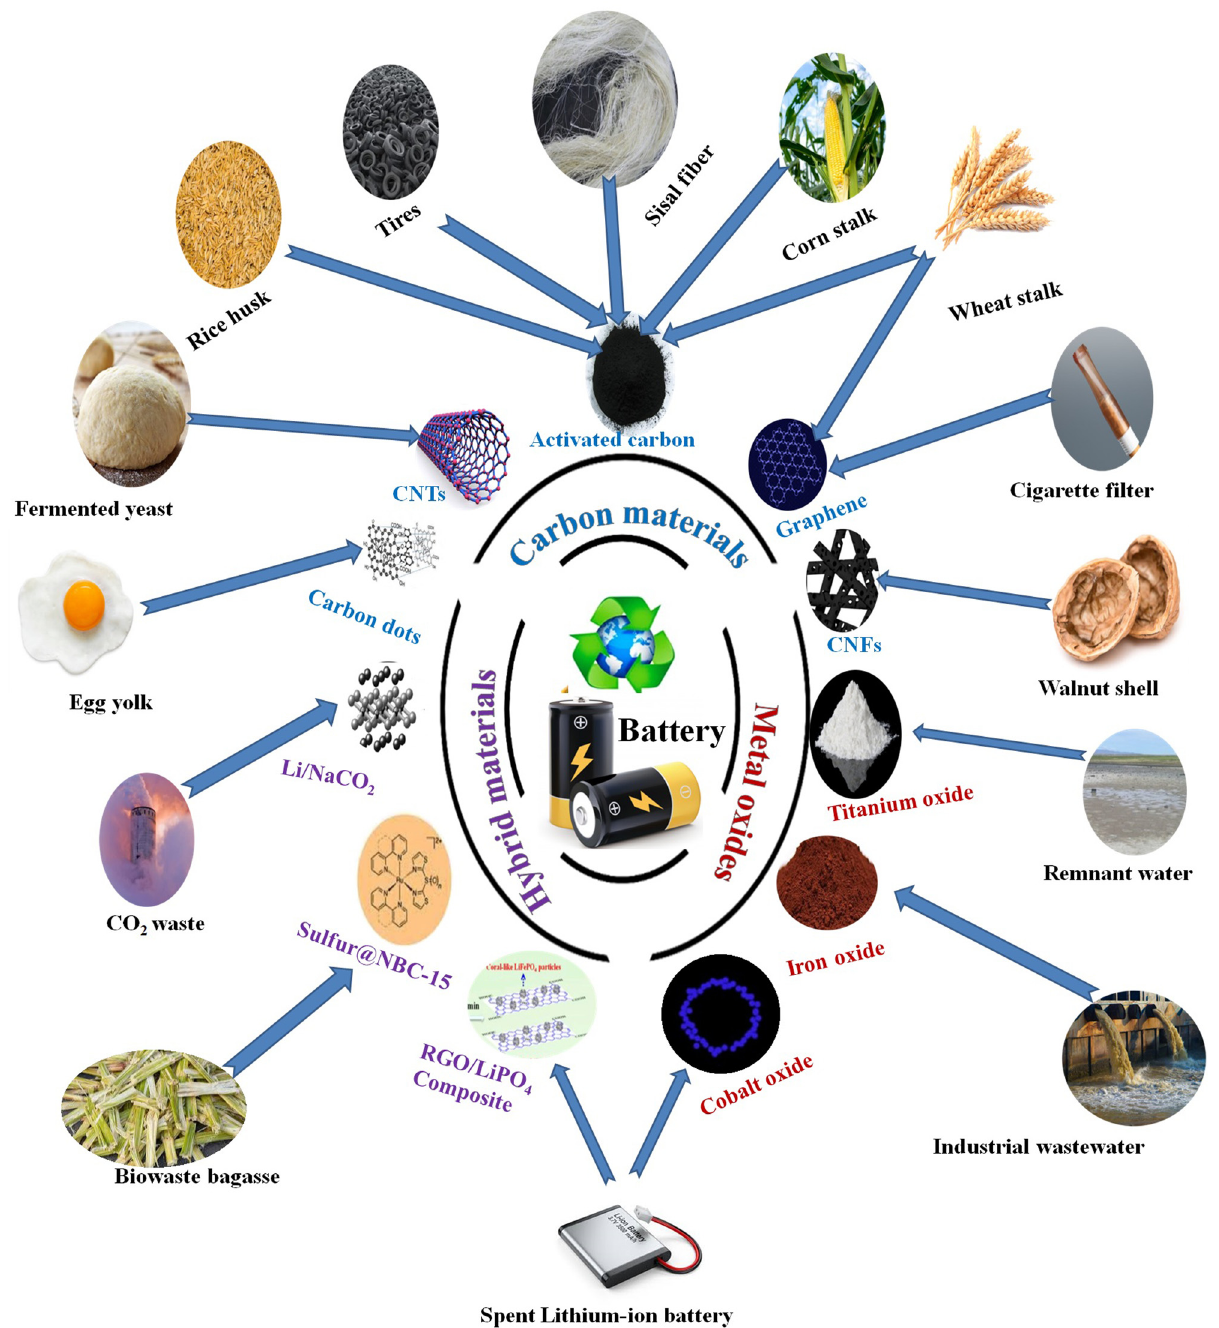
Figure 41: Schematic diagram of the primary waste sources used to fabricate battery electrode